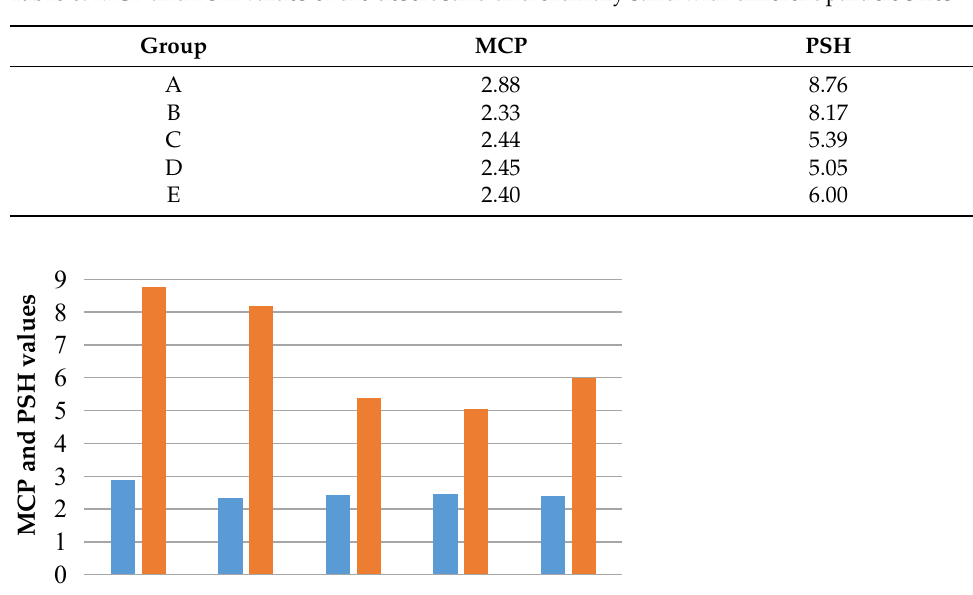
Table 6. MCP and PSH values of the desert sand and ordinary sand with different particle sizes.